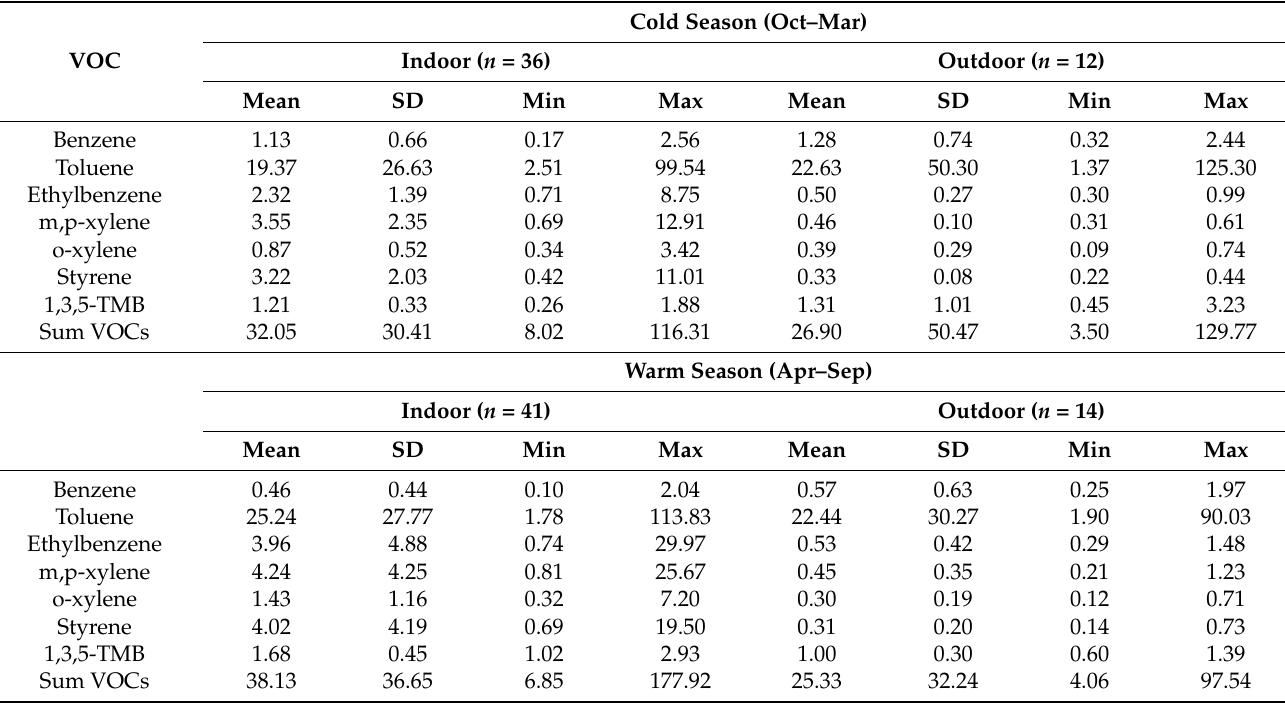
Table 3. Descriptive statistics of VOCs concentrations ( µ g/m 3 ) in offices and outdoor (cold (Oct–Mar) and warm